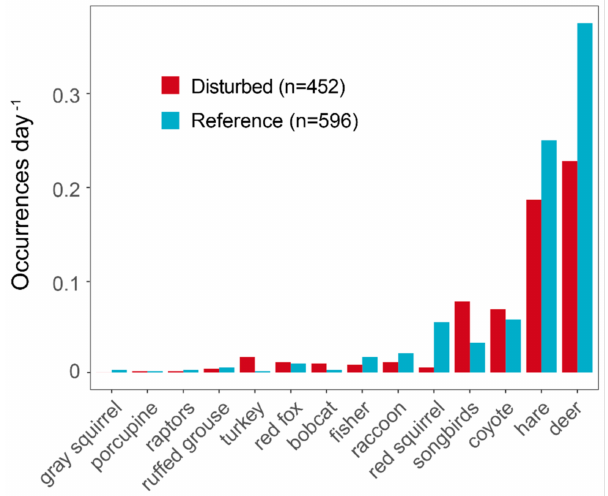
Figure 3. Species-specific wildlife occurrences per day in both disturbed and reference conditions from fall 2018 to summer 2020. The raptors category includes Cooper’s ( Accipiter cooperii , Bonaparte), red-tailed ( Buteo jamaicensis , Gmelin), and sharp-shinned hawks ( Accipiter striatus , Vieillet). The songbird category includes hermit thrush ( Catharus guttatus , Pallus), northern flicker ( Colaptes auratus , Linnaeus), dark-eyed junco ( Junco hyemalis , Linnaeus), cedar waxwing ( Bombycilla cedrorum , Vieillet), eastern phoebe ( Sayornis phoebe , Latham), American robin ( Turdus migratorius , Linnaeus), blue jay ( Cyanocitta cristata , Linnaeus), and American crow ( Corvus brachyrhynchos , Brehm). Refer to Table A1 for species-specific abundance in these